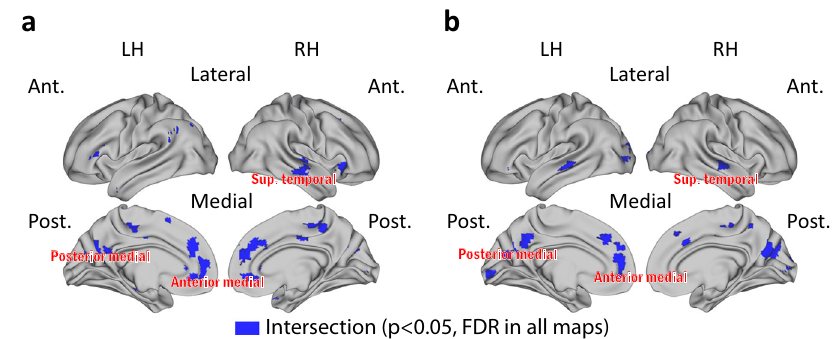
Fig. 6 Robust neural alignment effects in medial and temporal cortical regions emerge across all analyses. a Overlap regions across all three datasets and analyses for alignment-to-class. Blue color indicates voxels in the intersection set of the following maps: (i) correlation between alignment-to-class during lectures and exam scores (shown in Fig. 2d), (ii) correlation between alignment-to-class and alignment-to-experts during recaps (shown in Fig. 3c), (iii) correlation between same-question alignment-to-class during the fi nal exam and exam score (shown in Fig. 4d, left panel), and (iv) correlation between knowledge structure alignment-to-class during the exam and exam score (shown in Fig. 5c). b Overlap regions for same-question analyses, blue color indicates voxels in the intersection set of the following maps: (i) correlation between same-question alignment-to-class during the fi nal exam and exam score (shown in Fig. 4d, left panel) and (ii) correlation between same-question alignment-to-experts during the fi nal exam and exam score (shown in Fig. 4d, right